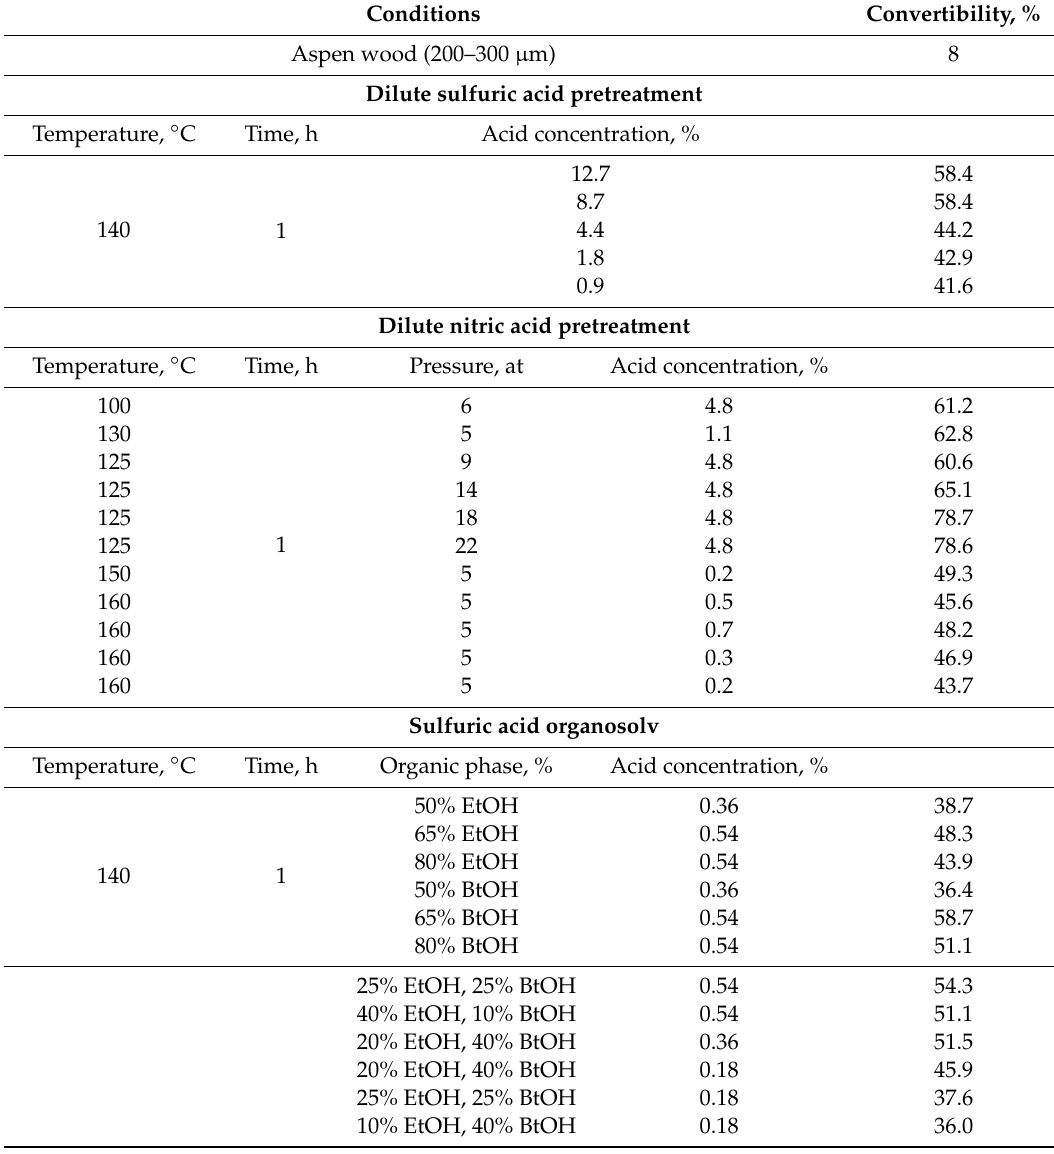
Table 3. Convertibility of aspen wood pretreated using di ff erent types of acid-containing solutions at elevated